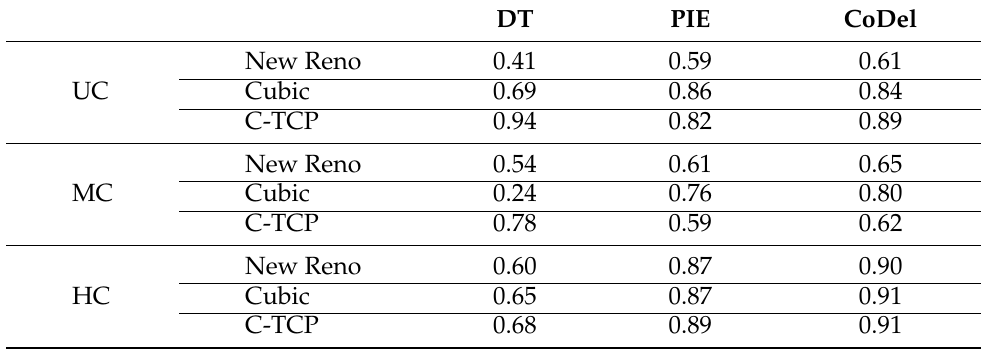
Table 7. Jain’s index (fairness) among long-lived flows in the Access Link scenario with common TCPs, UC–uncongested, MC—mildly congested, HC—heavily congested